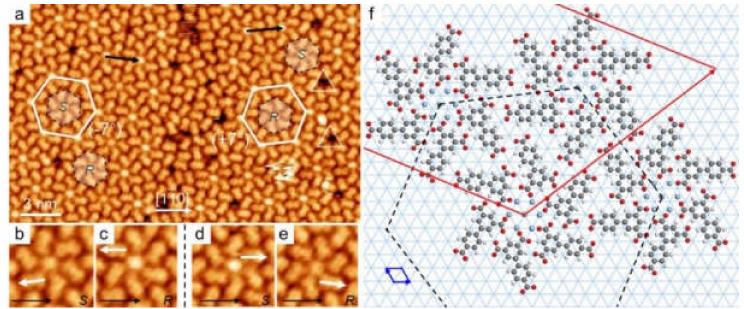
Figure 4. H2 structures after an annealing at 490 K. ( a ) STM overview ( U = − 1.2 V, I = 200 pA) of the H2 networks. White hexagons denote the two mirror symmetrical domains ( − 7 ◦ /+7 ◦ ). Dash hexagons indicate four different BTA -hexamers. ( b – e ) The four BTA -hexamers with different chiral characters, in which white arrows indicate the orientations of BTA monomers. The protrusions at the hexamer centers show different contrasts. The black arrows indicate the substrate [1–10] vectors. ( f ) Tentative structural model of a domain (+7 ◦ ) including four BTA -hexamers. Ag 7 clusters are represented by spheres in cyan. The red lines denote the unit cell of the H2 structure. The blue arrows indicate the substrate unit